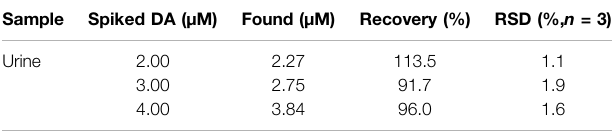
TABLE 1 | DA detection in urine samples with the proposed hPEI-Au NCs